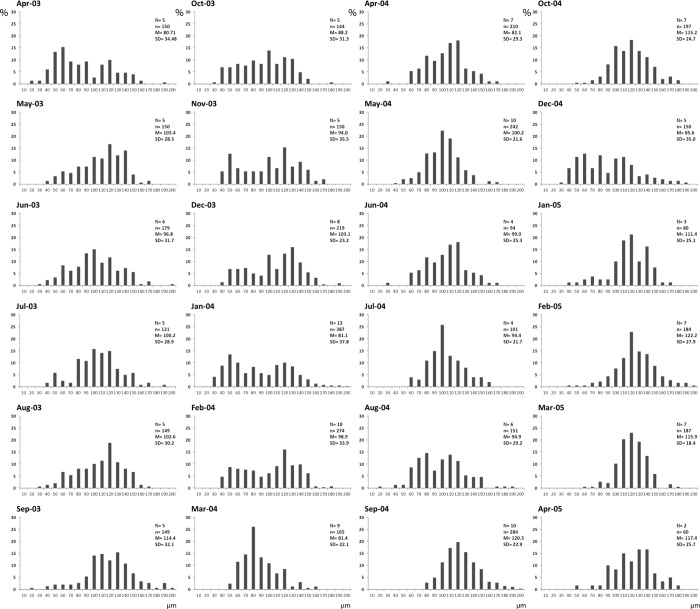
Oocyte size frequencies.N = total number of specimens examined; n = total number of oocytes examined; M = mean oocyte size (μm); SD = standard deviation.